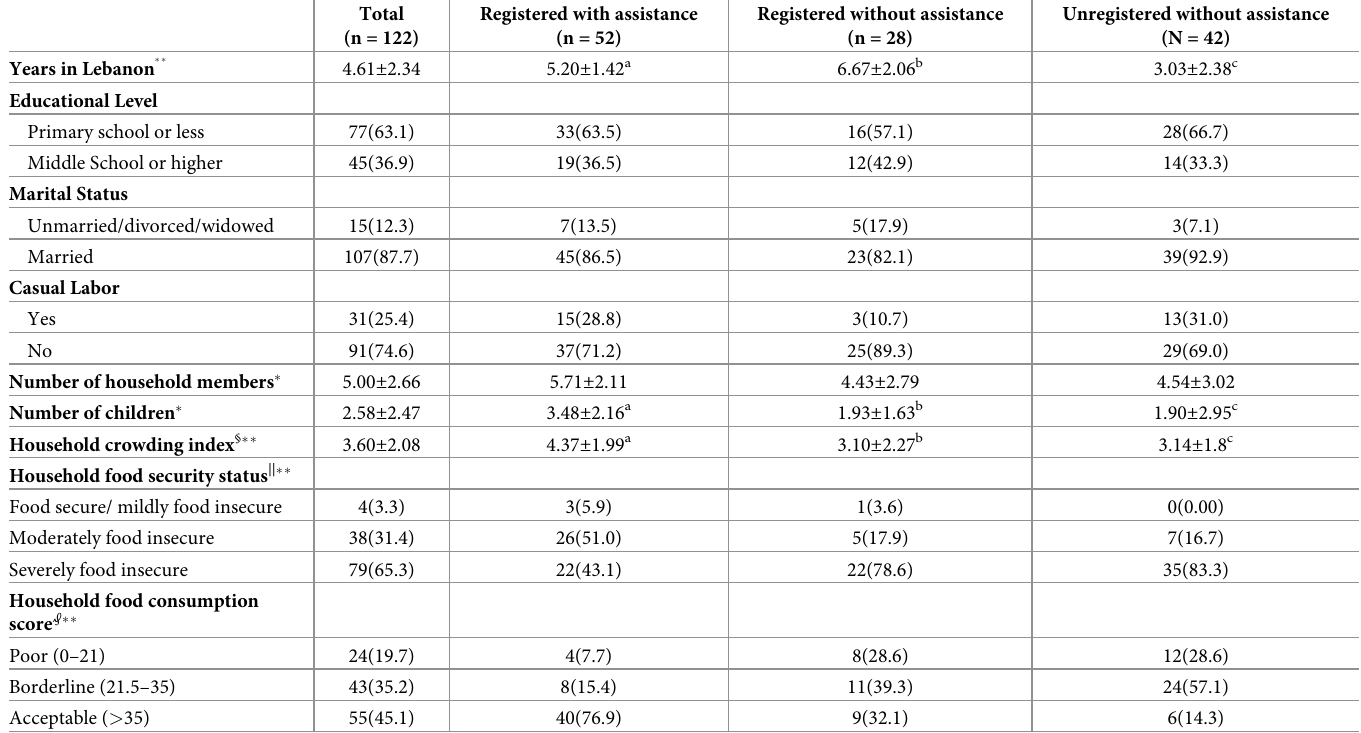
Table 2. Descriptive characteristics of Syrian refugees in the total sample and by registration and assistance